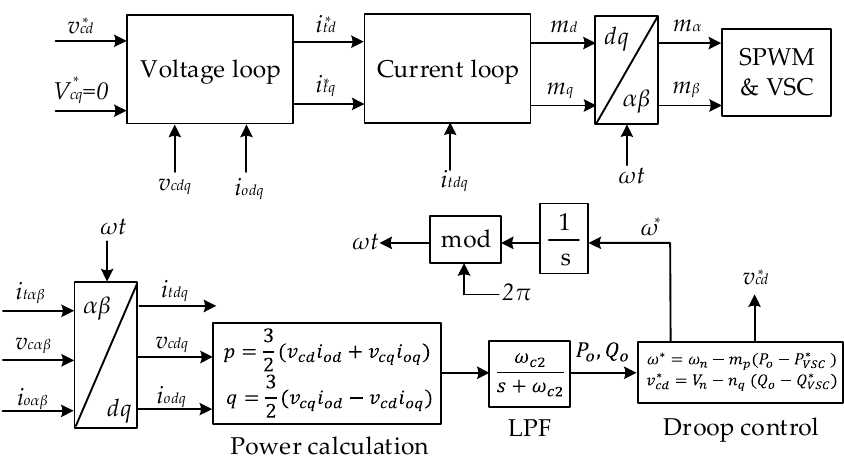
Figure 13. The VSC control system diagram.